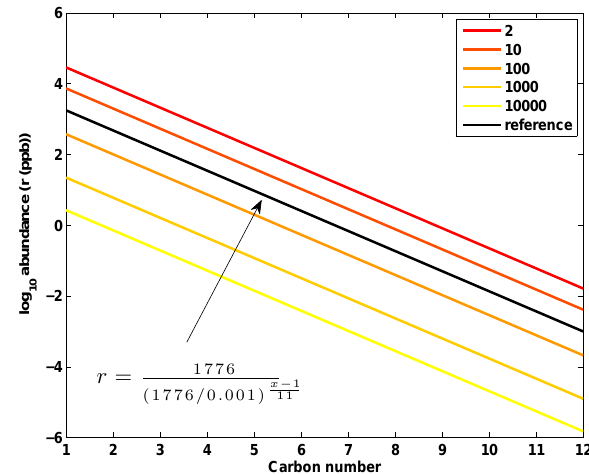
Fig. 2. The base case total mixing ratios of each compound of a given carbon number shown by the black line, demonstrating that the mixing ratios fall with carbon number ( x ) logarithmically as defined by Eq. (4). The other lines show that the mixing ratios re- quired to yield the “target” condensed loading of 10µgm − 3 at each level of complexity for any example initialisation run parallel to the base case “initial guess”. 2 and 10 compound representations of this initialisation require that the mixing ratio is increased above the “initial guess” values and that the 100, 1000 and 10000 compound representations correspondingly require successive lowering of the mixing